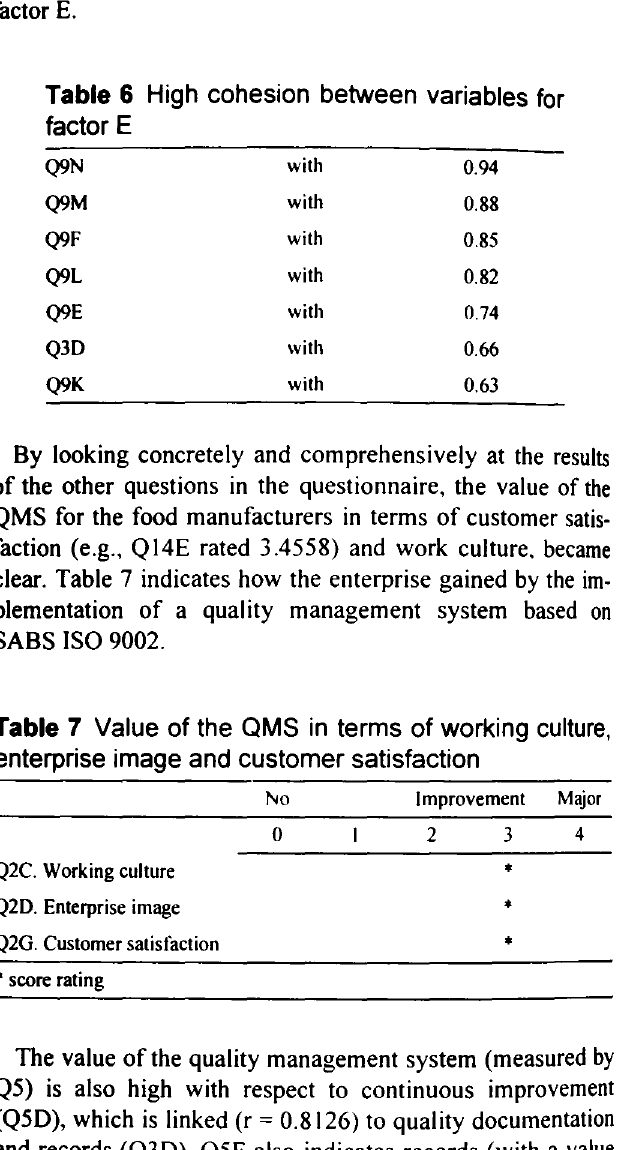
Table 6 indicates the high cohesion between variables for factor